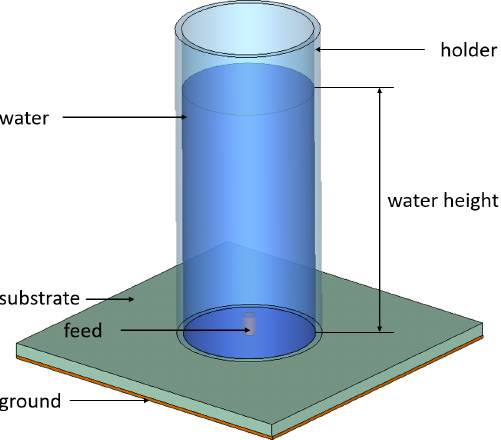
Figure 2. Schematic of a basic water-based monopole antenna